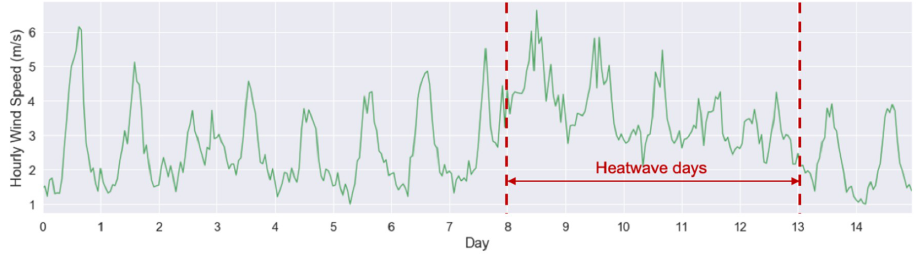
Figure 9. Relative humidity (%) distribution during the heat wave. ( a ): Temporal variation (averaged over all grids), ( b ) Spatial distribution.